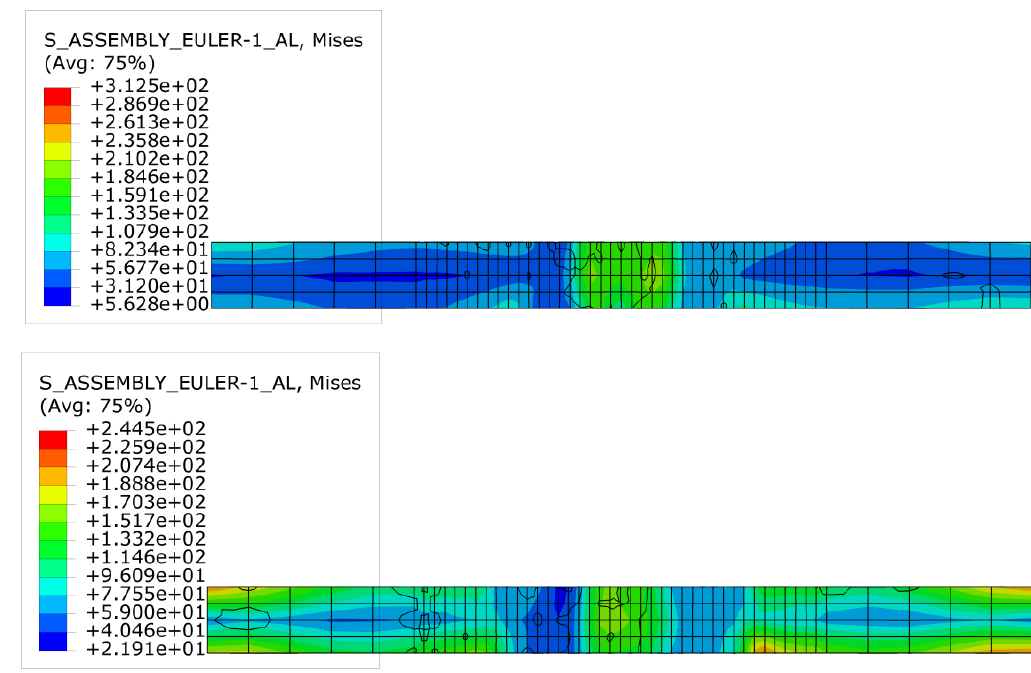
Figure 10. The distribution of the stress at the cross section.